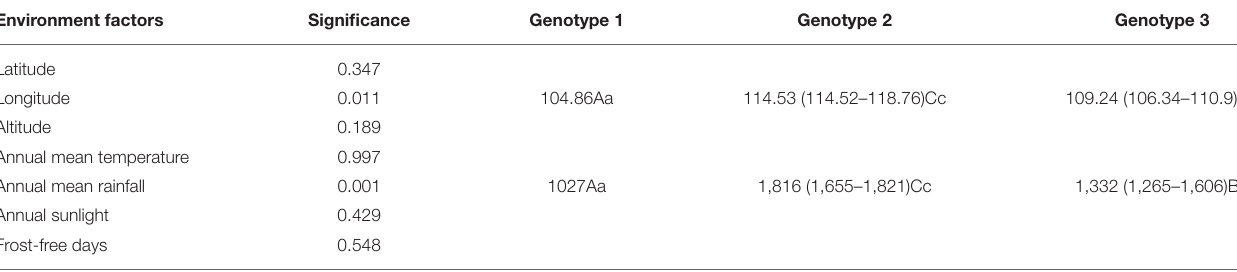
TABLE 6 | Kruskal–Wallis test and multiple comparisons between genotypes and environmental factors of C. paliurus .